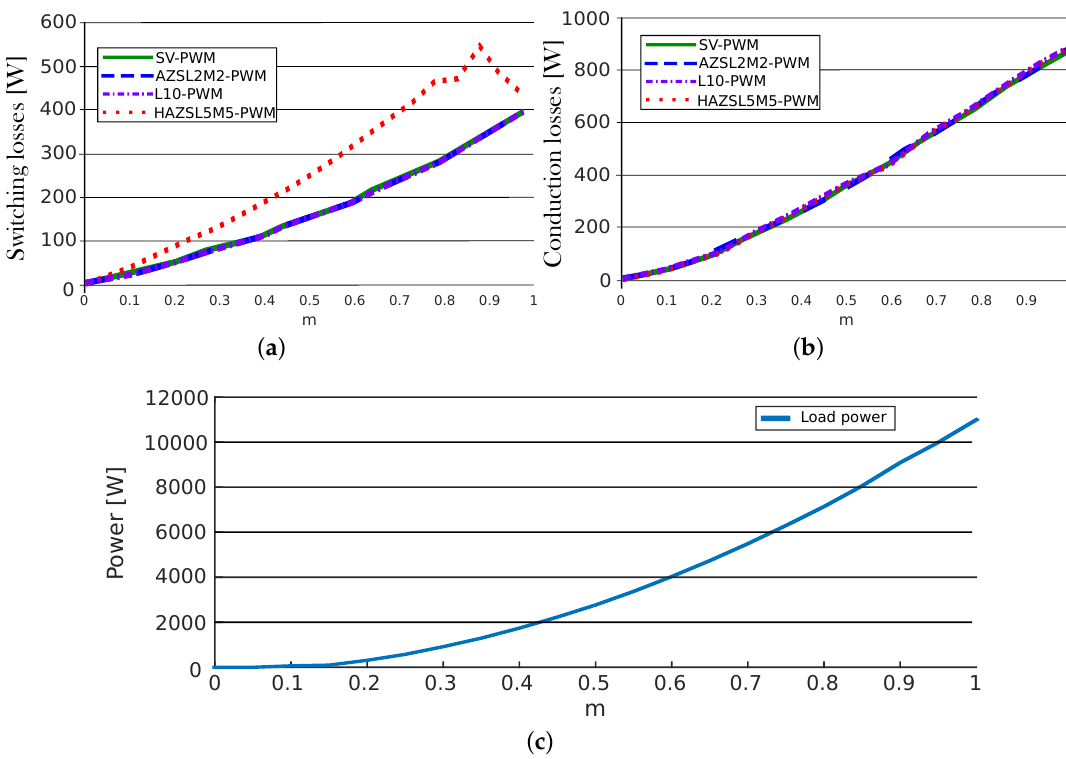
Figure 10. Distribution of power losses for the of studied modulation techniques for static operation points. ( a ) Switching losses. ( b ) Conduction losses. ( c ) Load power.